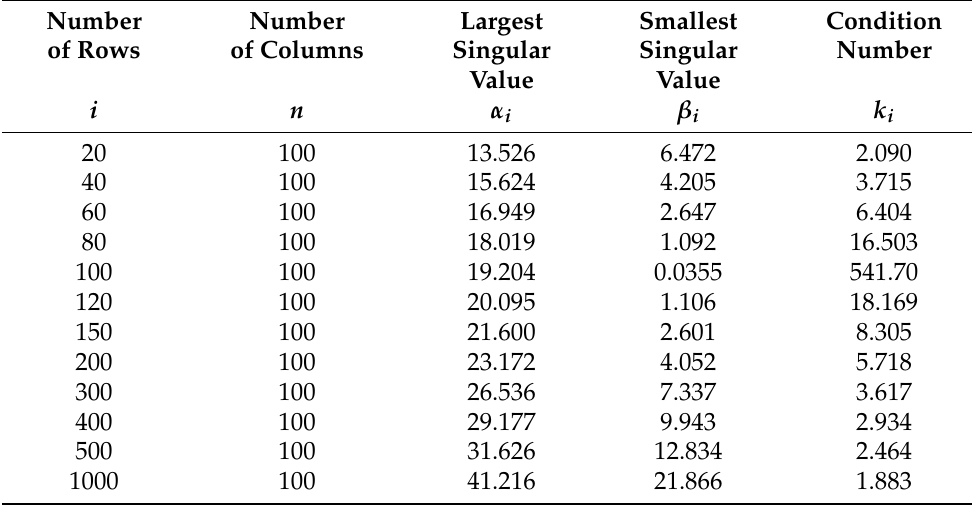
Table 7. The anomaly in random “ − 1 or 1”